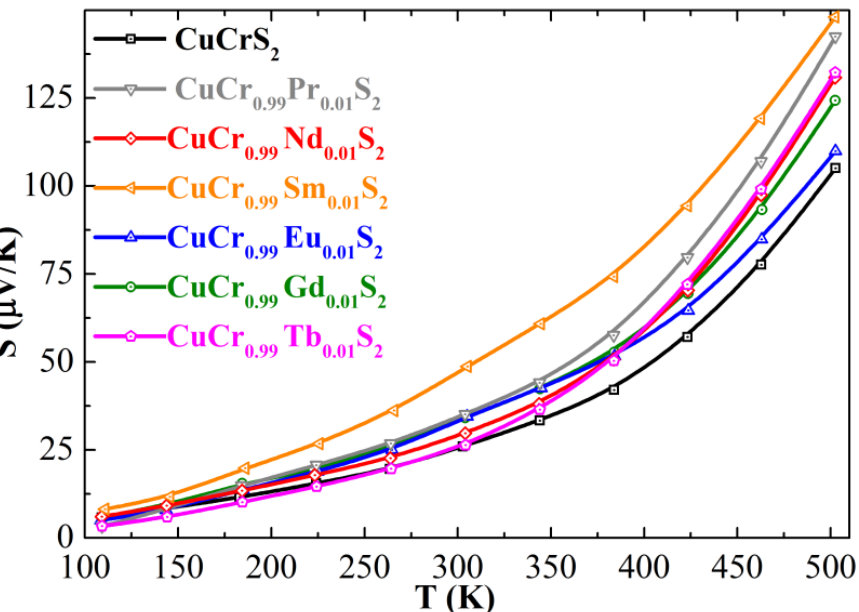
Figure 6. Seebeck coefficient temperature dependencies of CuCrS 2 and CuCr 0.99 Ln 0.01 S 2 (Ln = Pr–Tb) solid solutions.